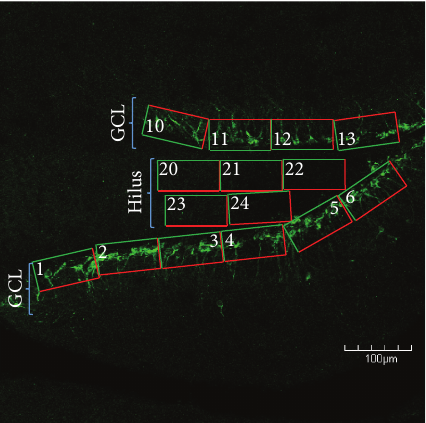
Figure 1: Confocal micrograph depicting the grid layout used to randomly select areas of the dentate gyrus in which newborn neurons were quantified. For each region of interest, we overlaid a series of numbered boxes. We then set the range of numbers in a random number generator and had it choose which grid numbers would be quantified at higher magnification. In this schema, the hilus and supra- and infrapyramidal blades of the granule cell layer (GCL) were quantified, in order to sample the entire dentate gyrus. Note that green portions of the grids are inclusion lines and red portions are exclusion lines. The grids along the GCL were positioned to include cells in the subgranular zone to the upper 3/5ths of the granule cell layer. The grids in the hilus were positioned to exclude cells in the subgranular zone, as DCX+ cells in this location are not necessarily hilar ectopic granule cells, and GFAP+ cells in this region typically display a morphology that is distinctly different than those in the hilus. It is pertinent to note that the apex and subjacent hilar areas are excluded from counting because cells in this region receive signals and cues from both the supra- and infrapyramidal blades of GCL. Scale bar = 100 𝜇